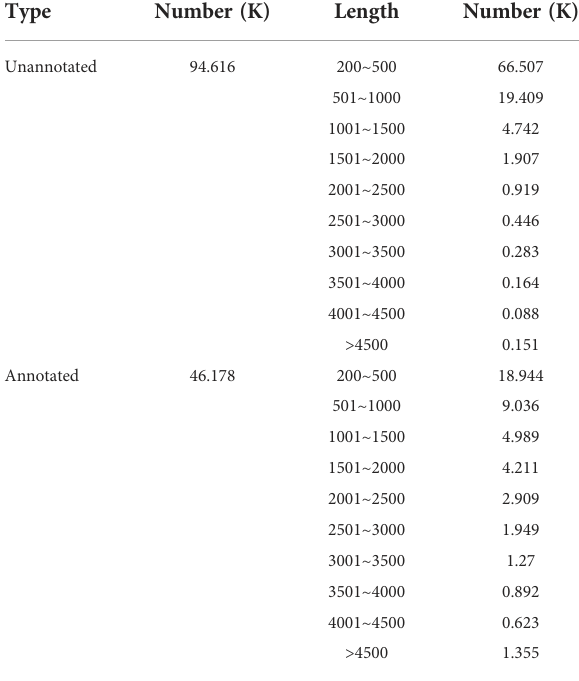
TABLE 4 Sequence length distribution and annotation statistics.